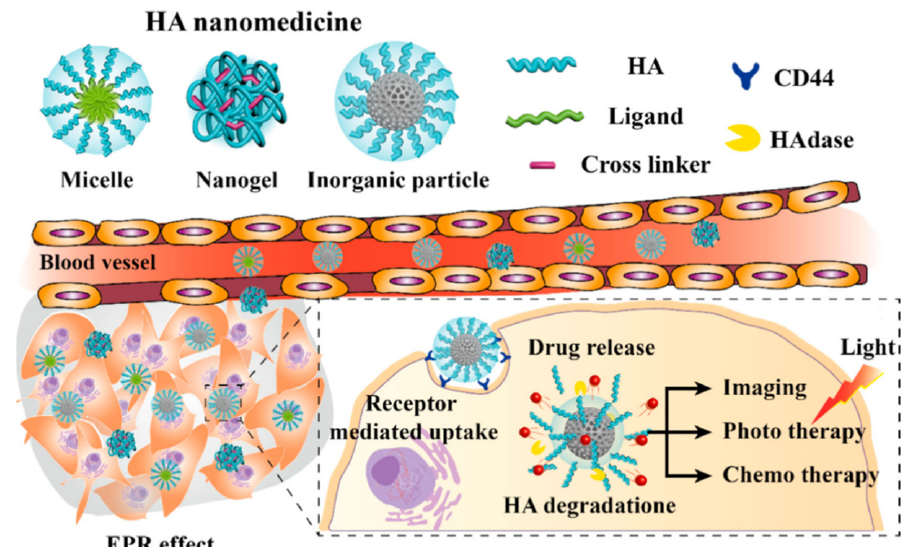
Figure 6. Schematic representation of the advantages and applications of hyaluronic acid (HA). EPR: enhanced permeability and retention; CD44: cluster determinant 44. Reprinted with permission from MDPI [98].